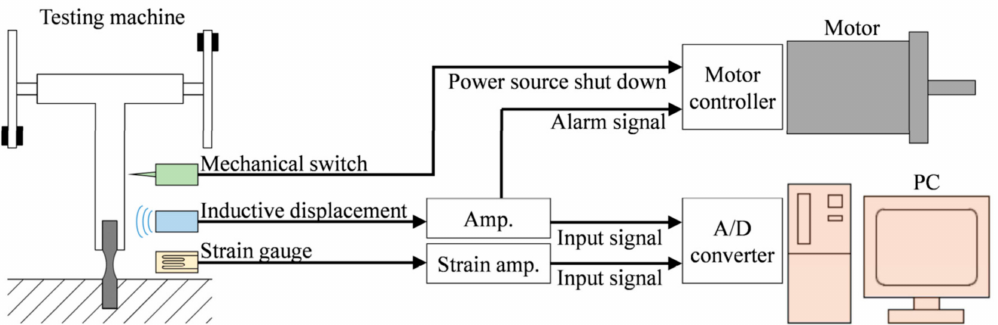
Figure 3. Measurement and control system for the testing